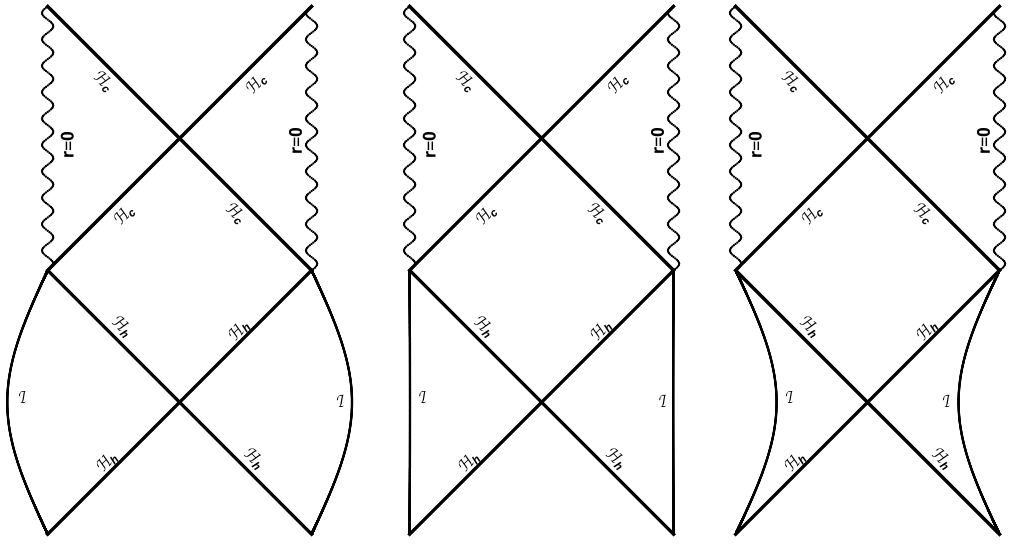
Figure 1 . Conformal structure of the ARNAdS black hole. The shape of the asymptotic region depends on θ and the black hole parameters. We parametrize the middle panel with a straight line at infinity and θ = π/ 2 . In the left and right panels θ = 0 and θ = π , respectively. H h and H c denote the event and Cauchy horizons,